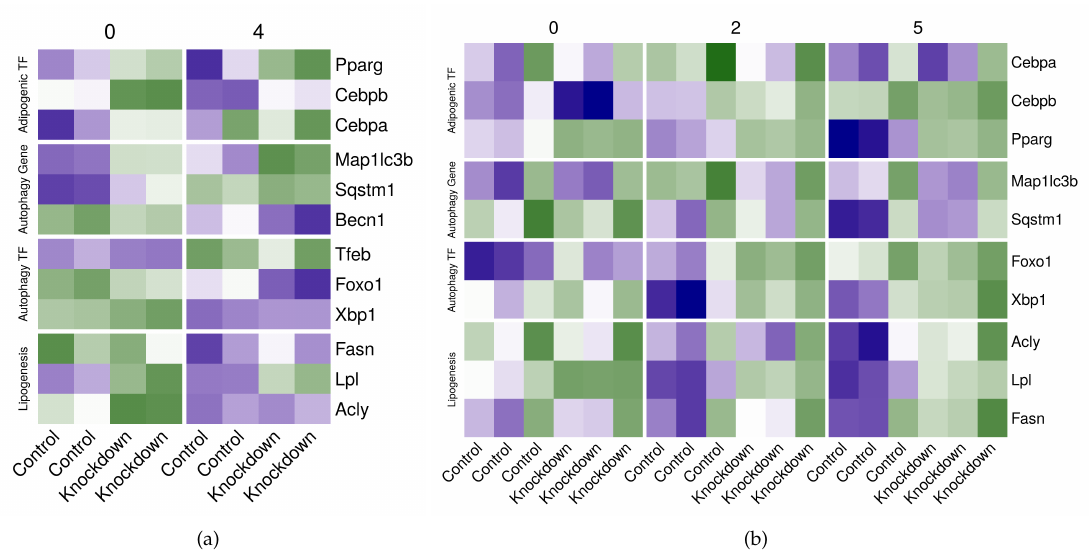
Figure 9. Expression of key adipogenic, autophagy and lipogenic genes in Cebpb or Pparg -knockdown adipocytes. ( a ) Reads count of selected genes from RNA-Seq samples (n = 8) of Cebpb -knockdown differentiating adipocytes at 0 and 4 h were scaled and shown as color values (low, green; high, blue). ( b ) Probe intensity of selected genes from microarray samples (n = 18) of Pparg -knockdown differentiating adipocytes at 0, 2 and 5 days were scaled and shown as color values (low, green; high, blue). Genes are indicated by symbols in rows and grouped in four categories (Adipogenic TF, Autophagy Gene, Autophagy TF or Lipogenesis). Sample group (knockdown vs. control) is indicated in rows and grouped by time points (0 or 4 h; and 0, 2 or 5